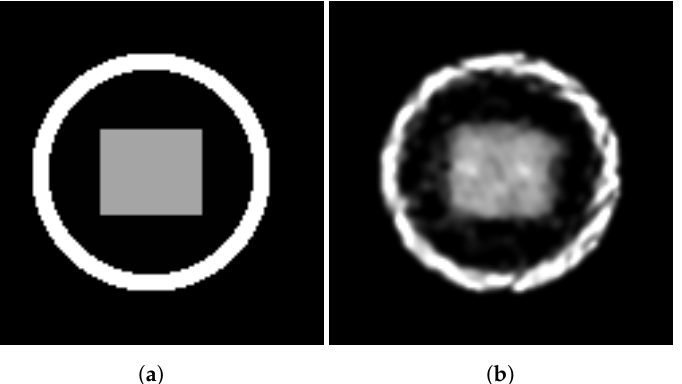
Figure 7. ( a ) Original phantom: ( b ) Reconstruction of the attenuation map from the ballistic